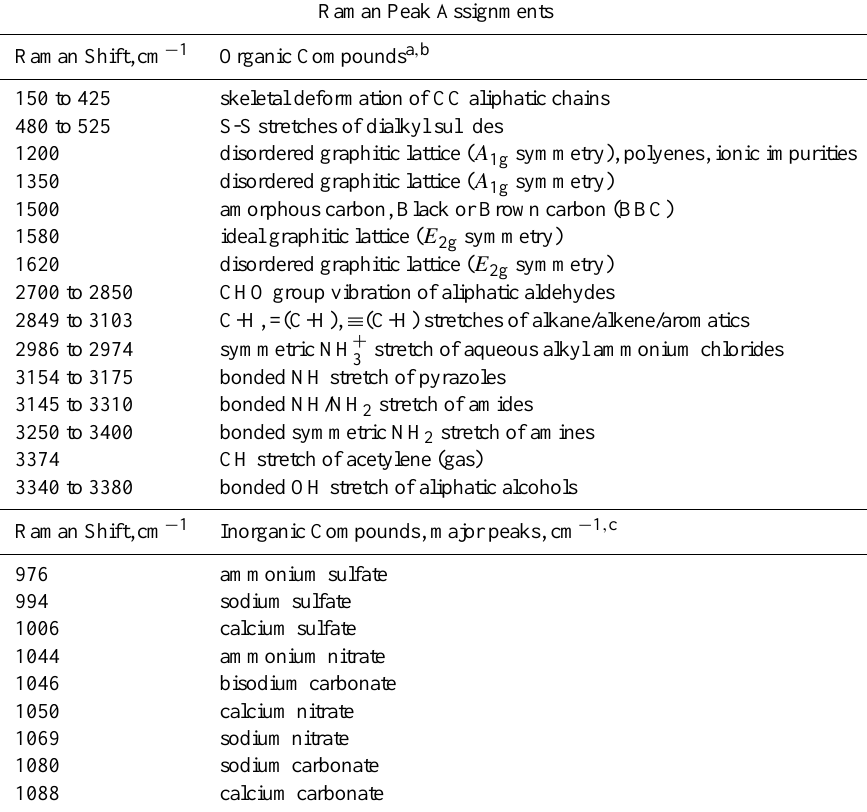
Table 1. Peak assignments for Raman shifts observed in this